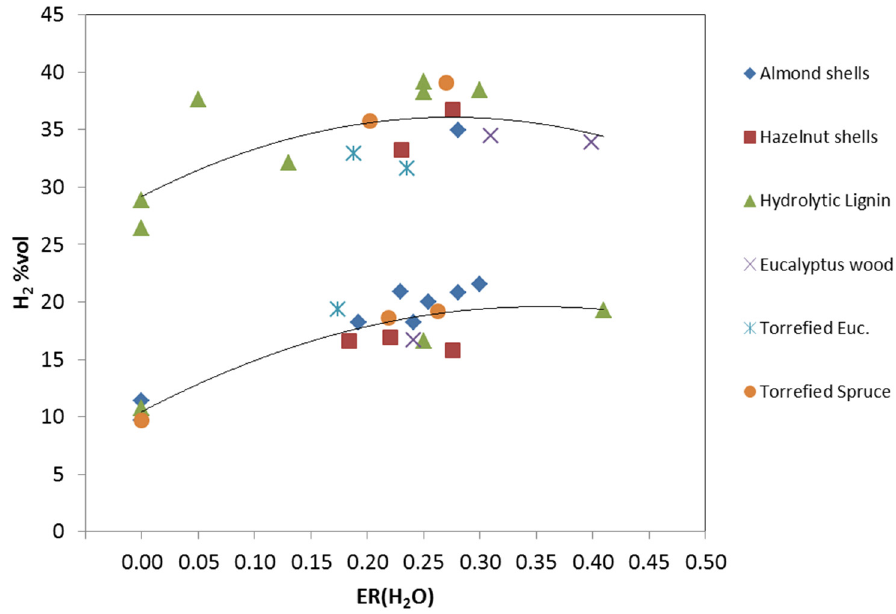
Figure 2. H 2 content in the syngas produced from the various feedstocks as function of the equivalence ratio ER(H 2 O), in the upper part of the plot are reported the experimental data of the oxy-gasification; in the lower part those of the air-gasification. Table 8. Yields of H 2 , CO and CO 2 per kg of dry feedstock as function of the equivalence ratio ER(H 2 O).